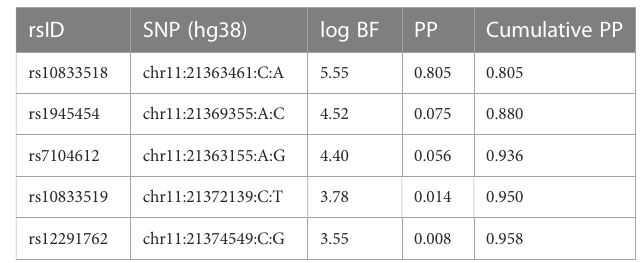
TABLE 1 Fine-mapping by Bayesian conditional probability of the genetic association signal in the chromosome 11 locus.